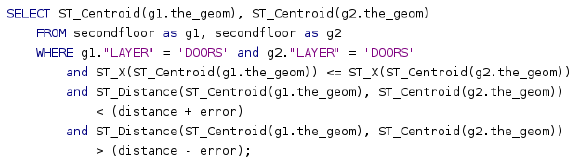
Figure 3. Query that is used to obtain the doors location at